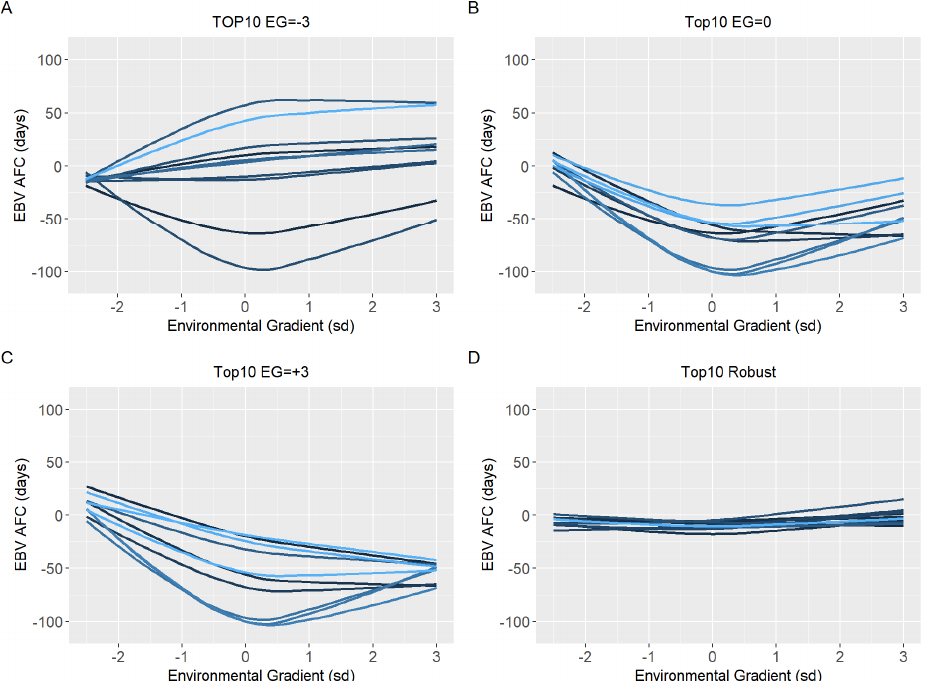
Figure 7. Estimated breeding values (EBV) reaction norms for age at first calving (AFC) of Nellore cattle sires classified as top 10 for low ( A ), medium ( B ), high EGs ( C ), and top 10 robust ( D ), considering the reaction norm models (RNM) fitted with spline linear–linear heteroscedastic (RNM_l-l).